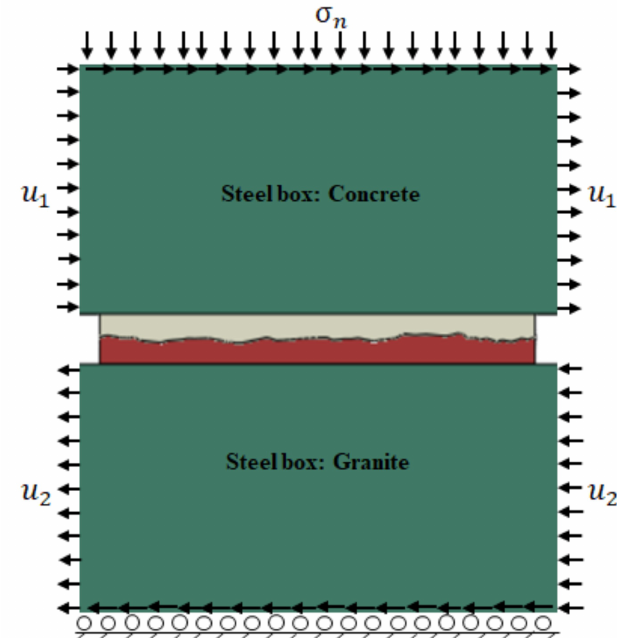
Figure 19. Boundary conditions—natural granite interface.